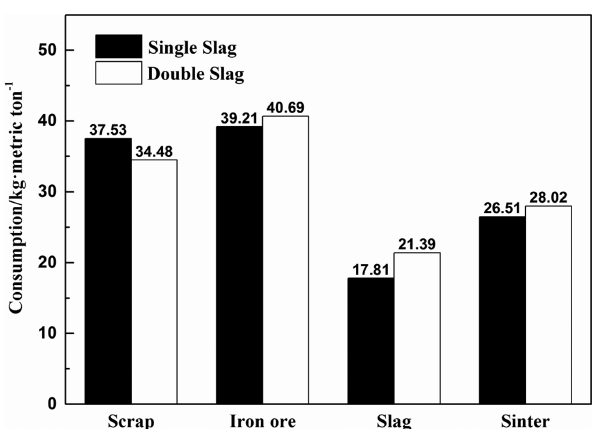
Figure 13: Comparison of metal material cost between single- and double-slag process.